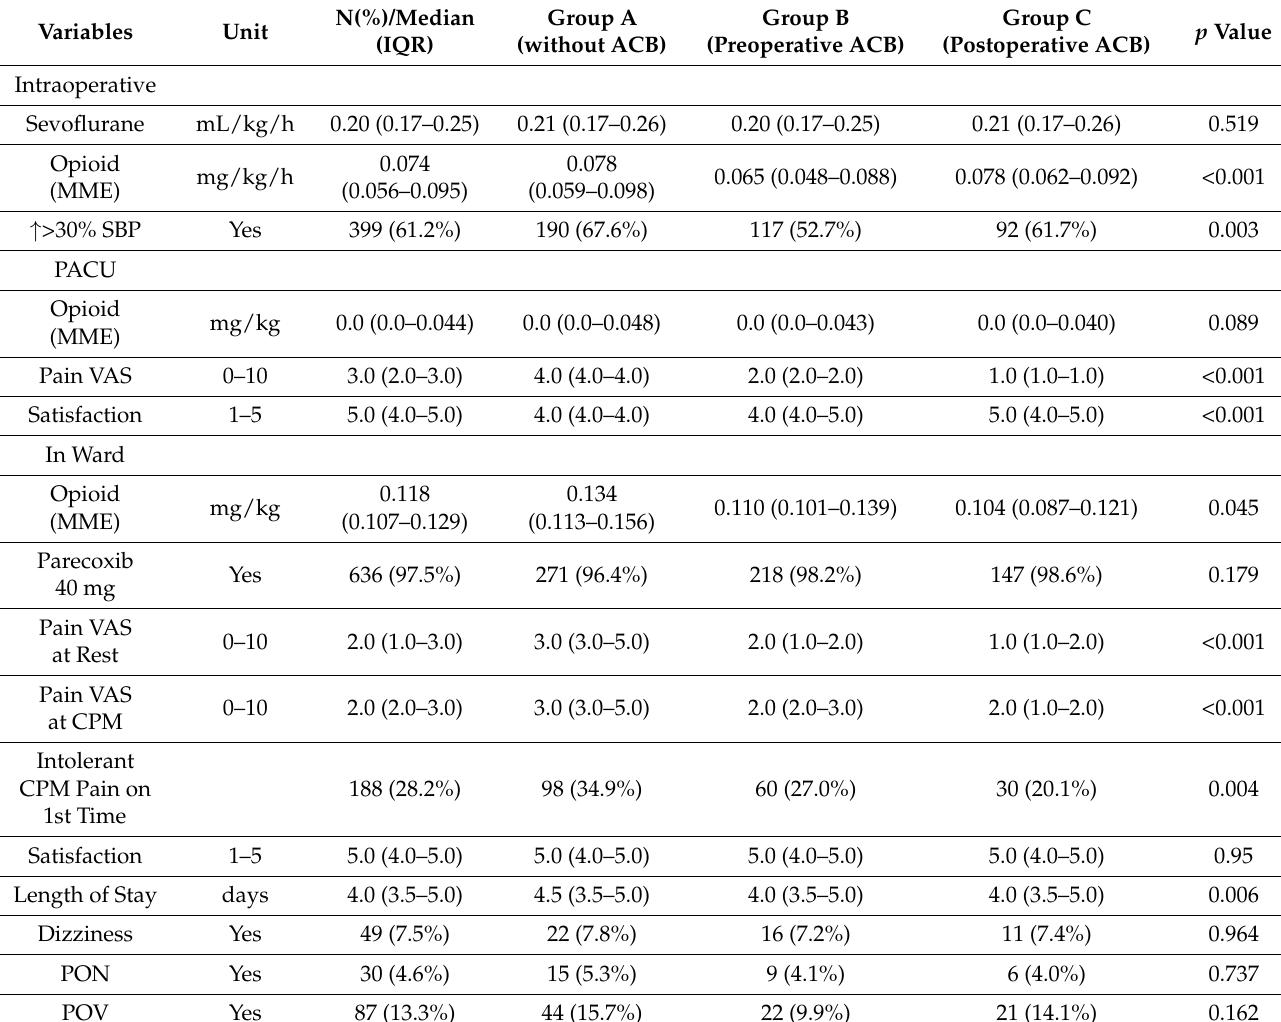
Table 2. Intraoperative and postoperative presentations of patients who underwent knee arthroscopic surgery under bispectral index-guided sevoflurane anesthesia without adductor canal block (ACB) (Group A), with preoperative ACB (Group B), and with postoperative ACB (Group